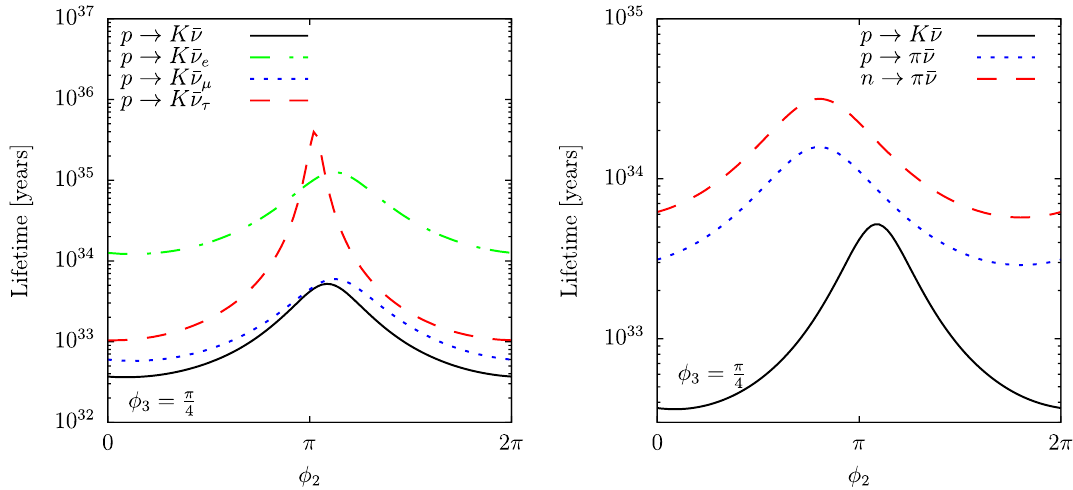
Fig. 9 Left panel: sensitivity of the p → K + ¯ ν partial lifetimes to the GUT phase φ 2 for the same point considered in Fig. 8. Right panel: comparison of partial lifetimes for p → K + ¯ ν (black solid line), p → π + ¯ ν (blue dotted line) and n → π 0 ¯ ν (red dashed line) as functions of φ